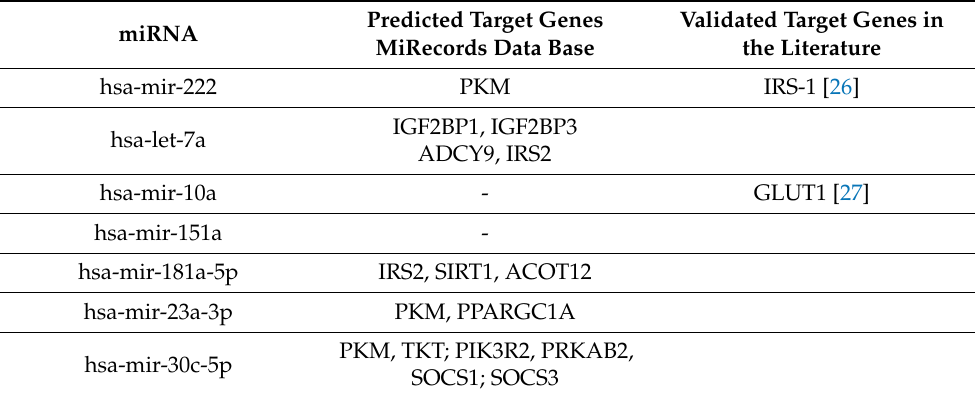
Table 1. Predicted target genes according to the MiRecords database and validated target genes found in the literature for the microRNAs analysed in the present study, which are related to glycaemic